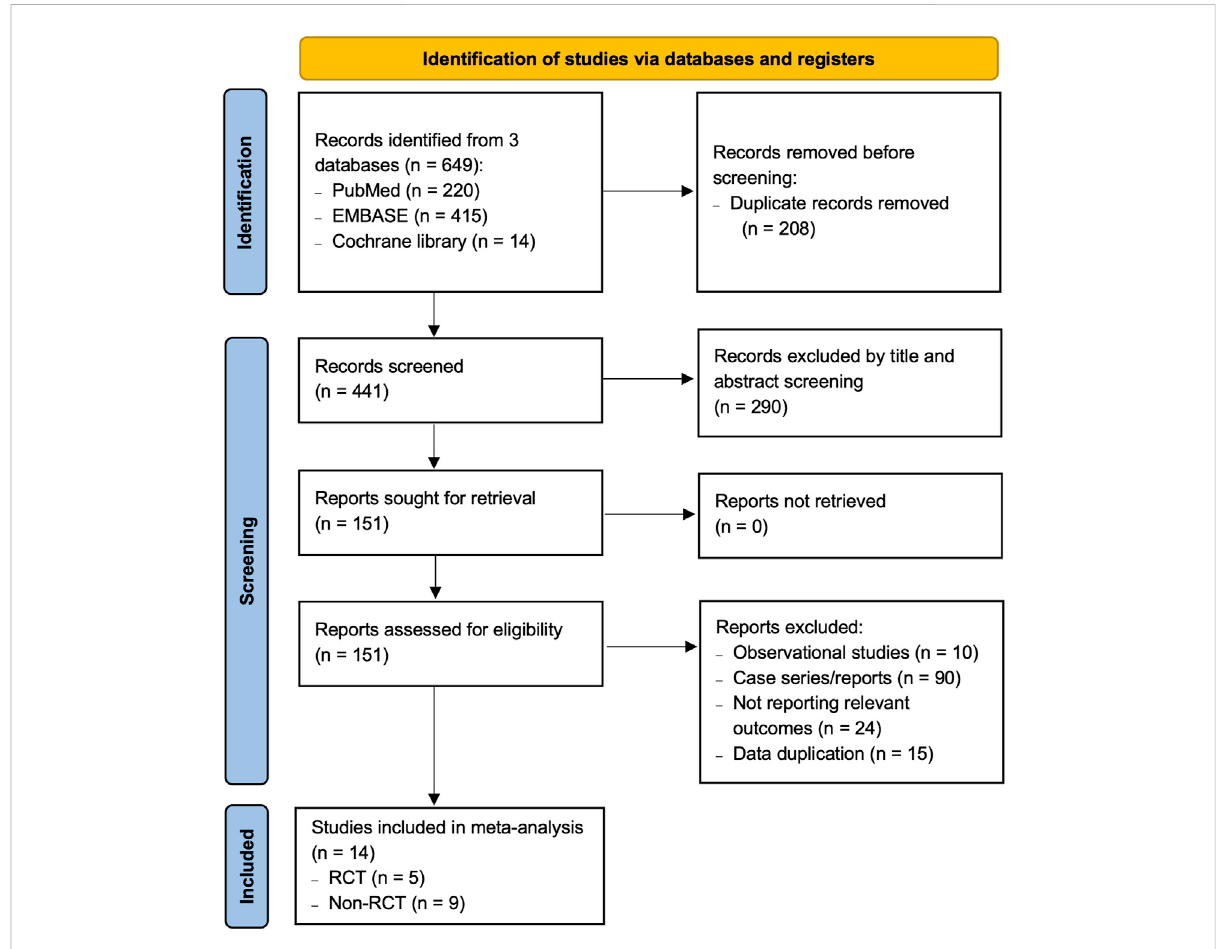
FIGURE 1 PRISMA fl ow diagram of record selection